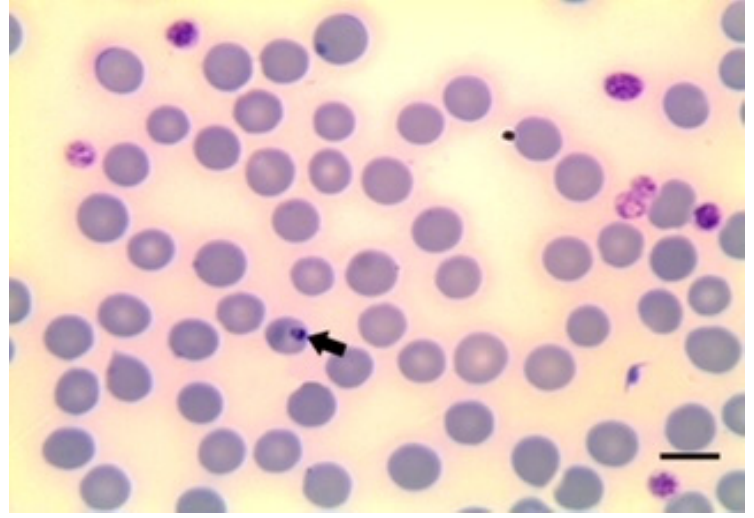
Figure 3. B. motasi in erythrocytes. Scale bar indicates 5 μ m. Image courtesy of Professor Khaled El- Dakhly, Beni-Suef University, Egypt.